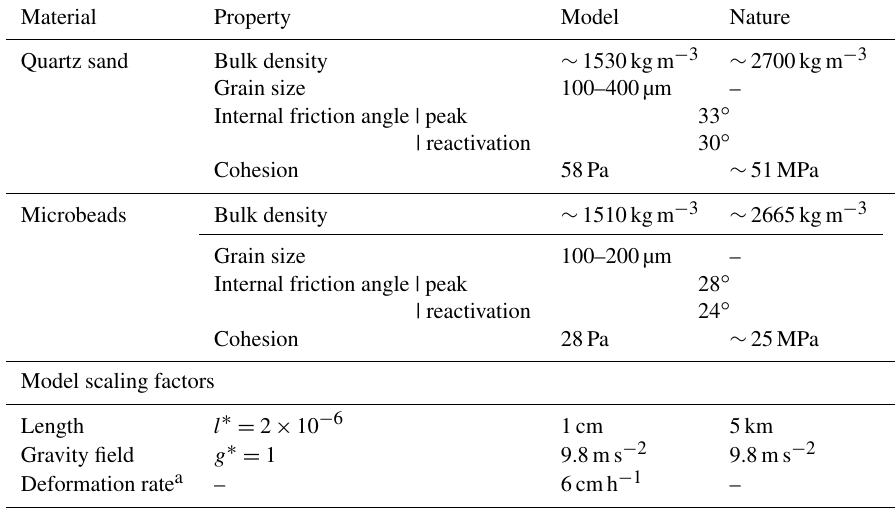
Table 1. Material properties and scaling